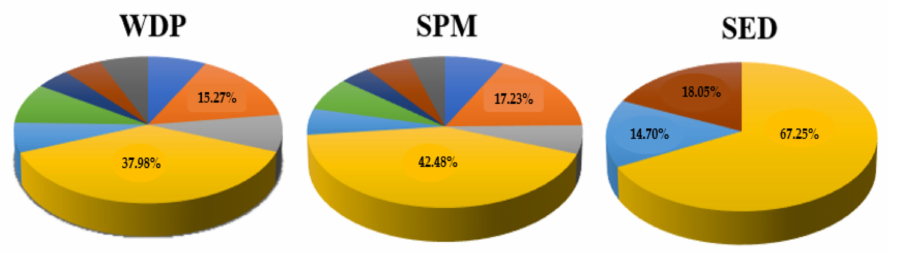
Figure 2. Total OPP amount % detected for each analyte in WDP (water dissolved phase), SPM (suspended particulate matter), and SED (sediment) of the Sele River, Southern Italy in 10 sampling sites and four